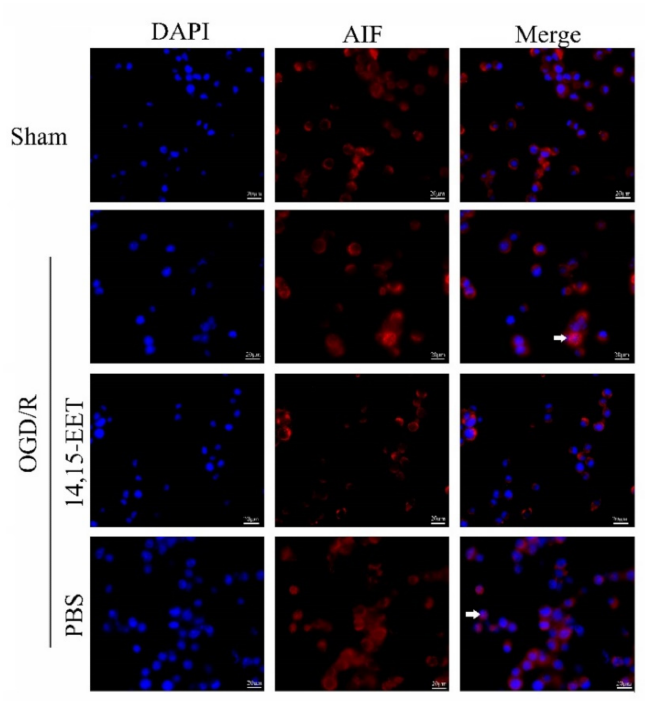
Figure 5. AIF nuclear translocation was detected with immunofluorescence method in primary cortical neurons at 24 h after OGD/R. Arrows point to the nuclear translocation of AIF. 14,15-EET pretreatment reduced the nuclear translocation of AIF in primary cortical neurons at 24 h after OGD/R.